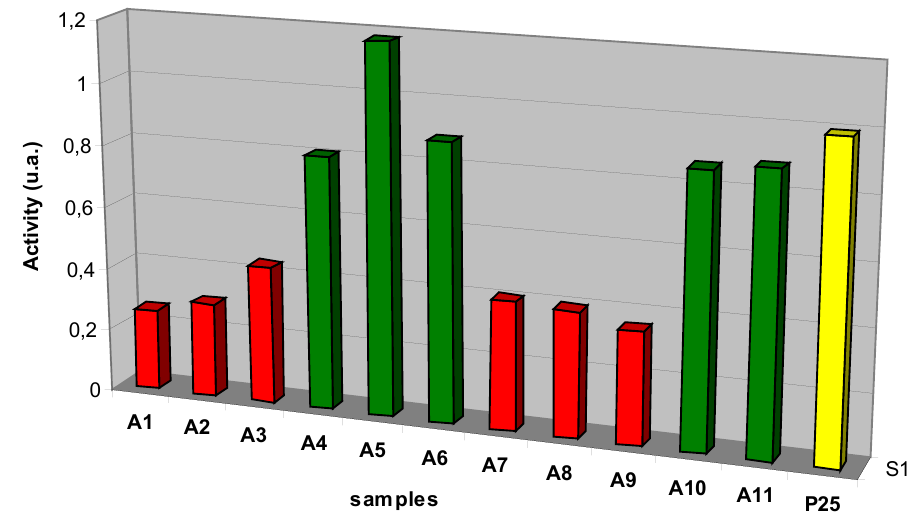
Figure 7. Relative photocatalytic activities for conversion of NO of distinct TiO